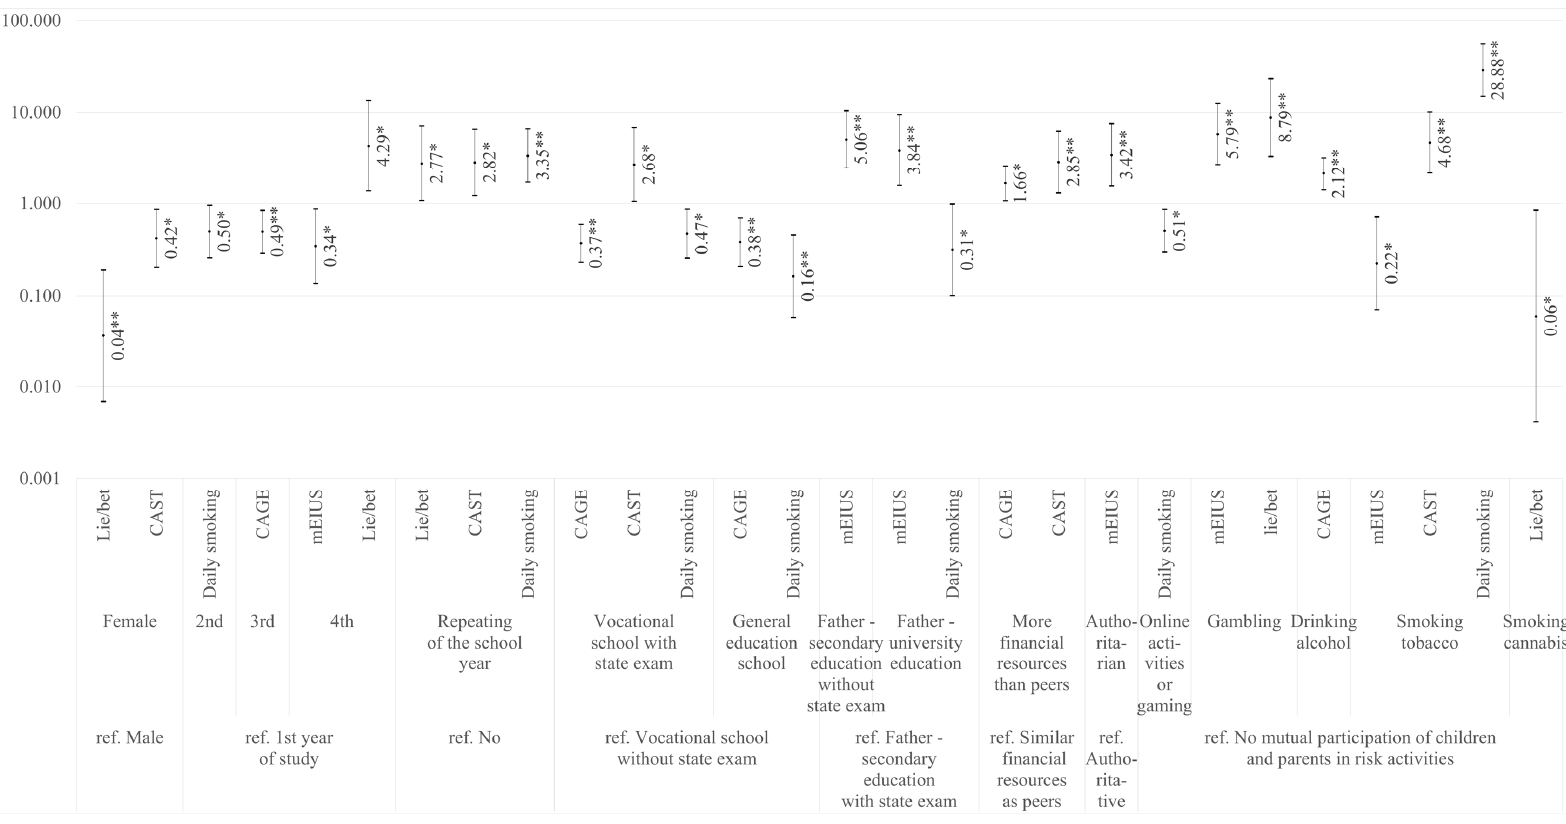
Figure 1. Odds ratios with 95% CI in multinomial regression models of mEIUS, Lie/bet, CAST, CAGE, and daily smoking for the statistically significant relationships; * statistically significant at 0.05 level; ** statistically significant at 0.01 level.